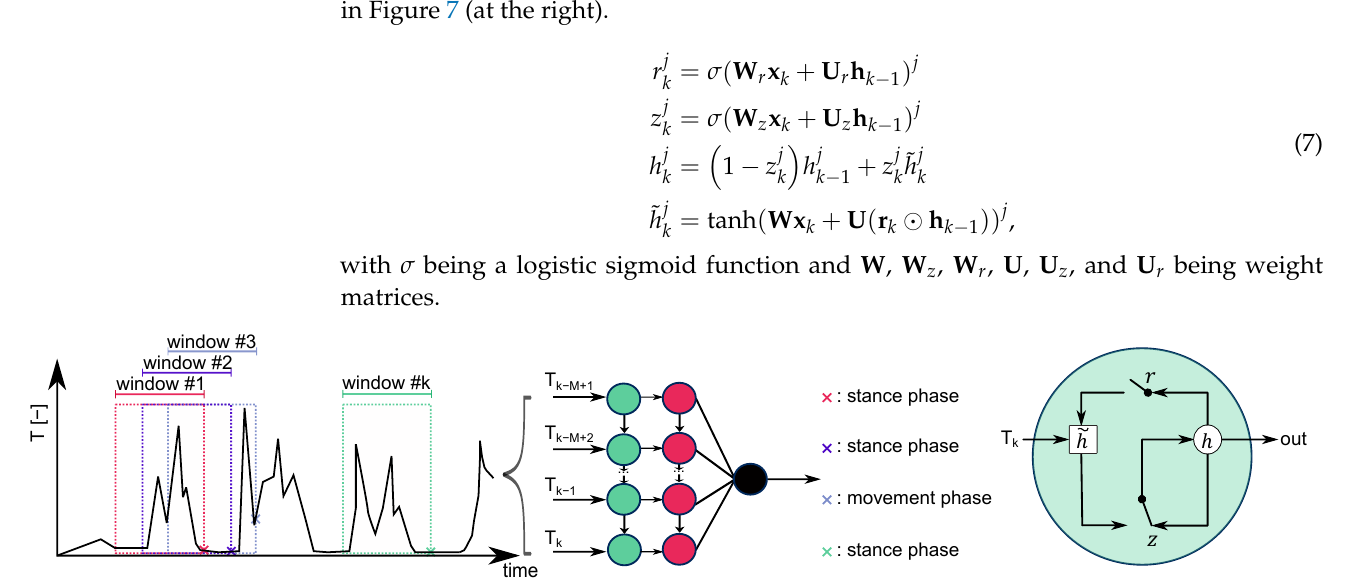
Figure 7. On the left, the concept of a recurrent-neural-network (RNN)-based zero-velocity detector is shown. M refers to the length of the sequence. On the right, the structure of a gated recurrent unit (GRU) cell (adapted from [43]) is illustrated, showing the context between the reset gate r , the update gate z , the activation h , and the candidate activation ˜ h